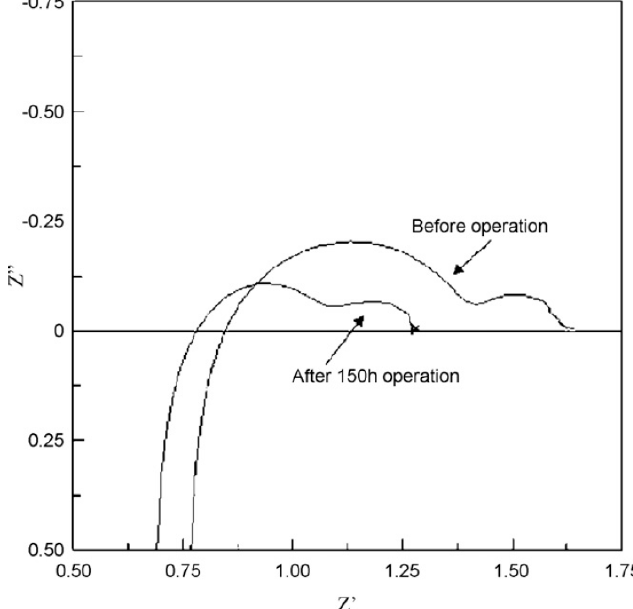
Figure 10. Impedance spectra of Ni–YSZ/YSZ/GDC/LSCF–Ag before operation and after 150 h operation at 730 °C. (Reprinted with permission from [36], 2008, Elsevier).